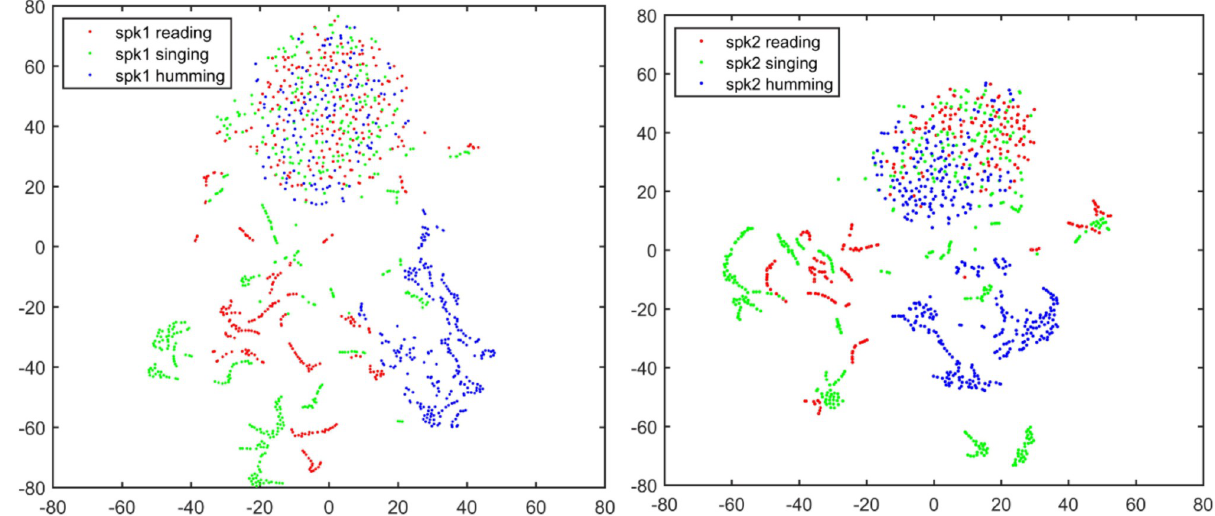
Fig 3. t-SNE visualization of two speakers’ features under text-independent condition. The texts are the same for each speaker with three speaking styles.